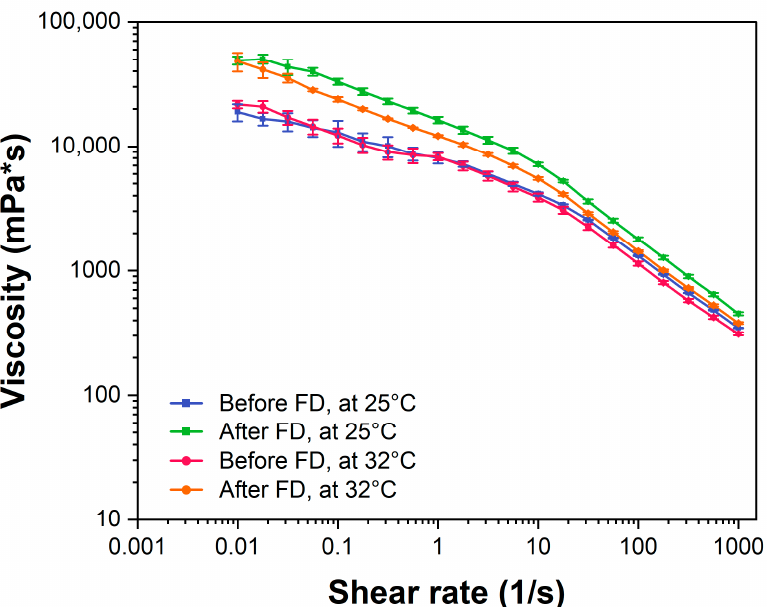
Figure 8. Comparison of the viscosity of the nanostructured HPMC gel before and after freeze-drying at two different temperatures (25 °C and 32 °C) (mean ± SD, n = 3).